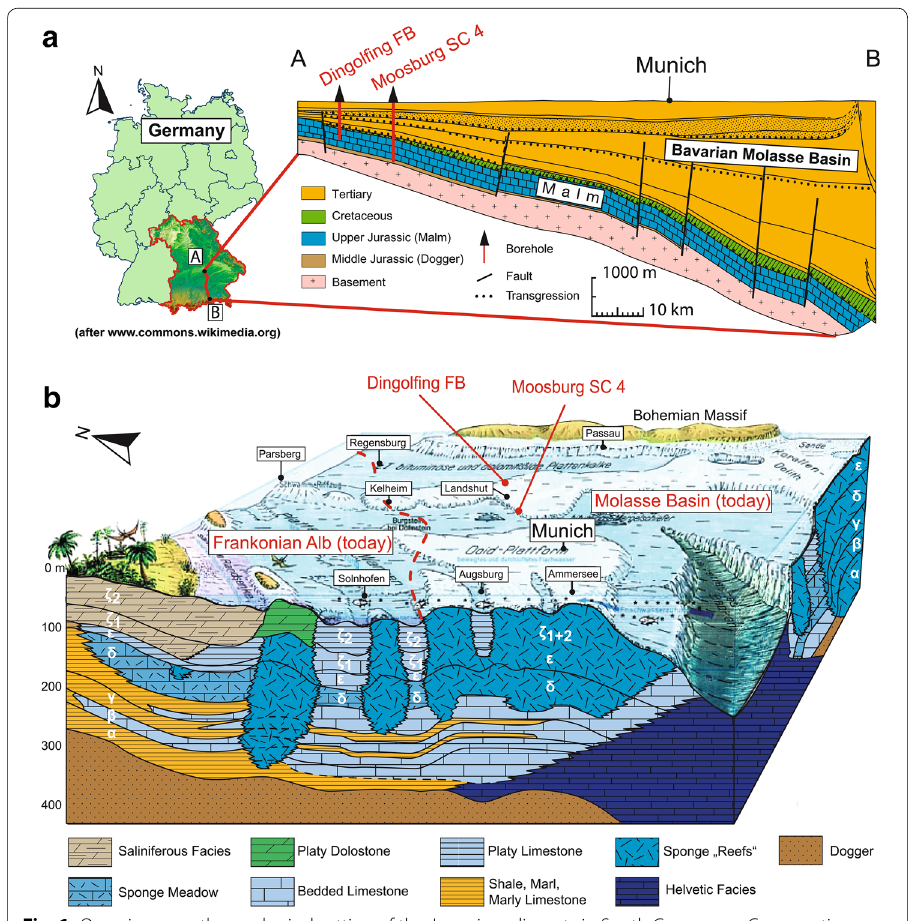
Fig. 1 Overview over the geological setting of the Jurassic sediments in South Germany. a Cross section through the South German Molasse Basin (from BayStMivt 2012; modified after Lemcke 1988). b Distribution of the calcareous Malm deposits during the uppermost Jurassic. Note the heterogeneity of depositional sequences due to local development of reefal buildups in alternation with restricted lagoons and small enclosed basins (modified after Meyer and Schmidt-Kaler